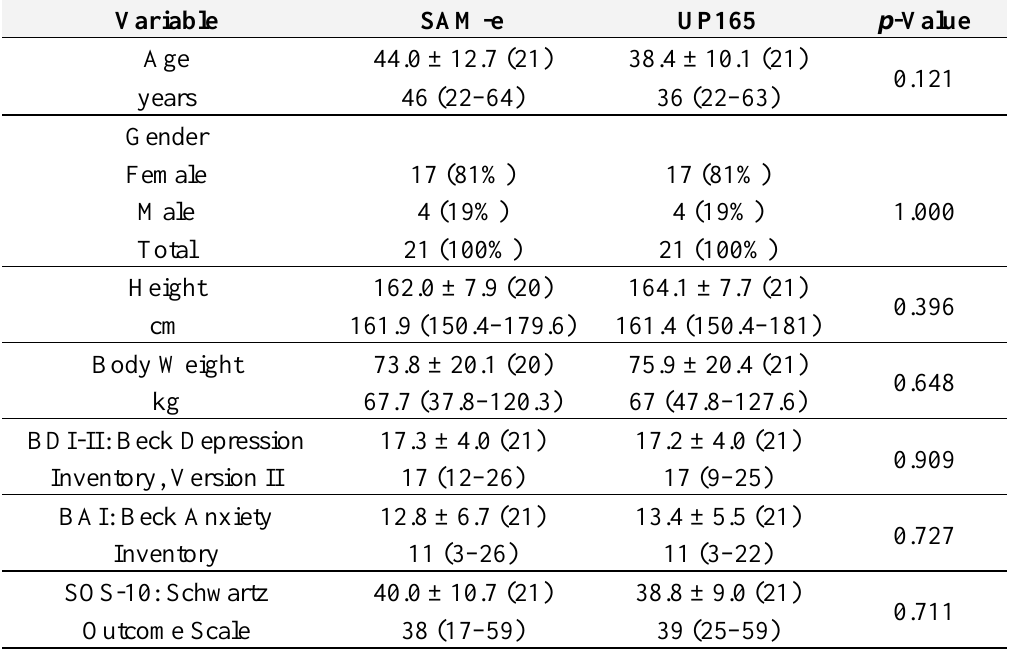
Table 1. Baseline demographics and characteristics.